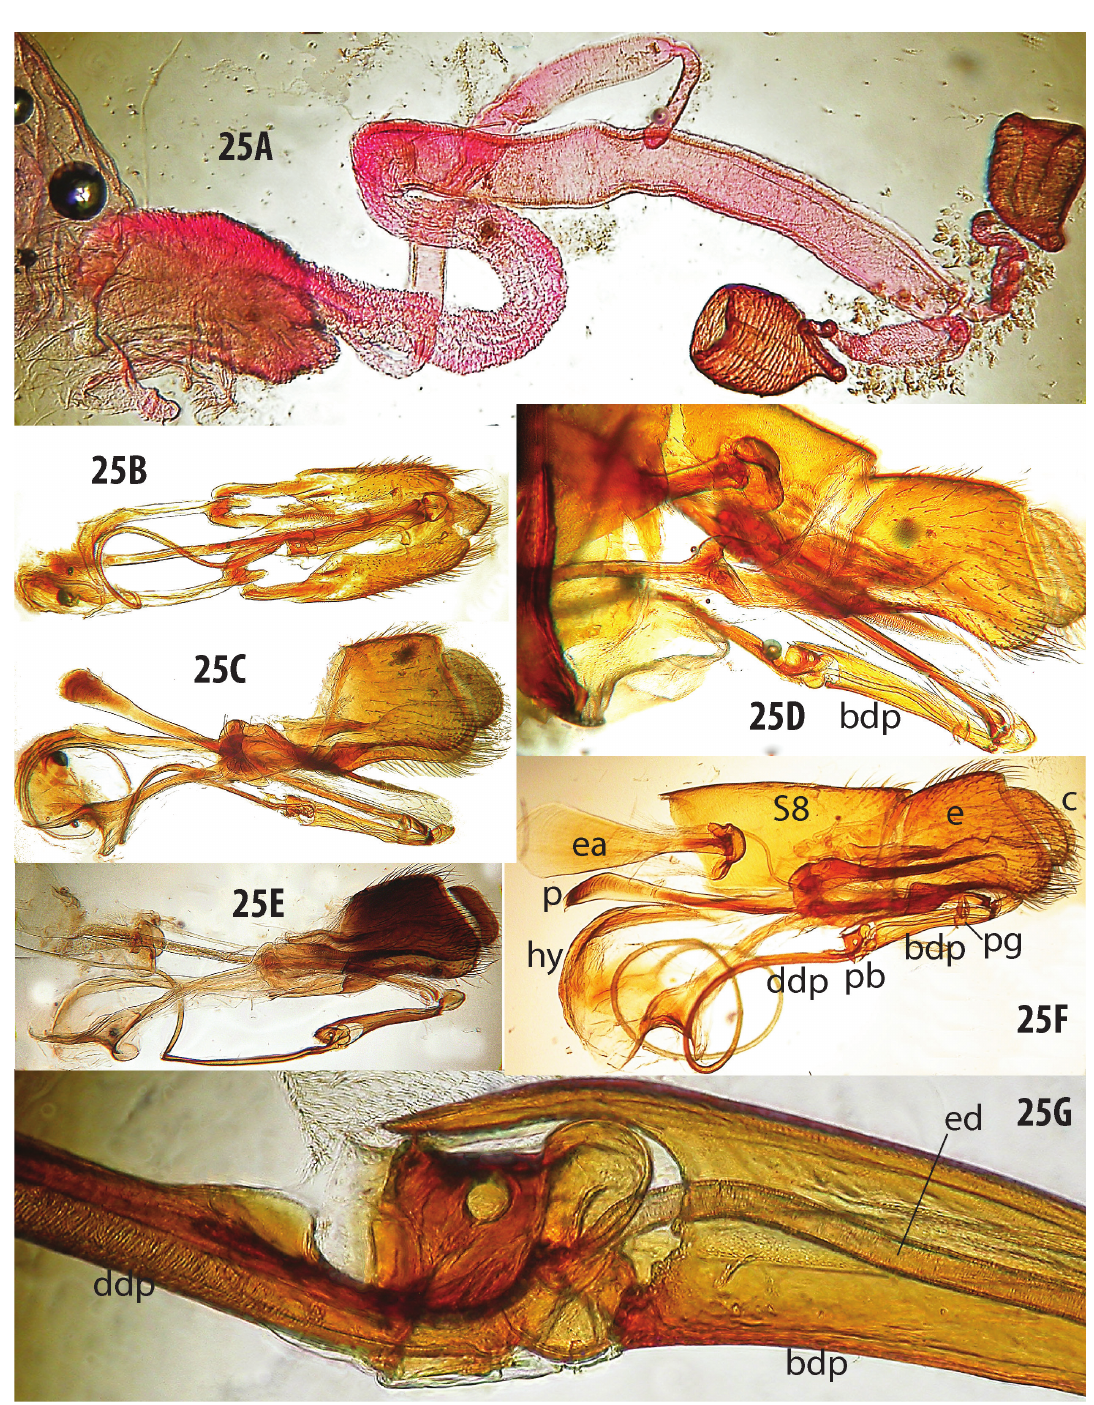
Fig. 25. Mesoconius infestus Enderlein, 1922 (species complex), internal characters. A . Spermatheca and associated structures, specimen from Bolivia. B–C . Epandrium, hypandrium and associated structures, dorsal and lateral views, specimen from Colombia. D . ♂, apex of abdomen, specimen from Bolivia. E . Epandrium and associated structures, specimen from SierrAzul, Ecuador, DEBU. F . Male terminalia, including S8, specimen from Baeza, Ecuador, DEBU. G . Detail of basal distiphallus and phallic bulb, specimen from Ecuador, DEBU. Abbreviations: bdp = basal distiphallus; c = cercus; ddp = distal distiphallus; e = epandrium; ea = ejaculatory apodeme; ed = ejaculatory duct; hy = hypandrium; p = phallapodeme; pb = phallic bulb; pg =